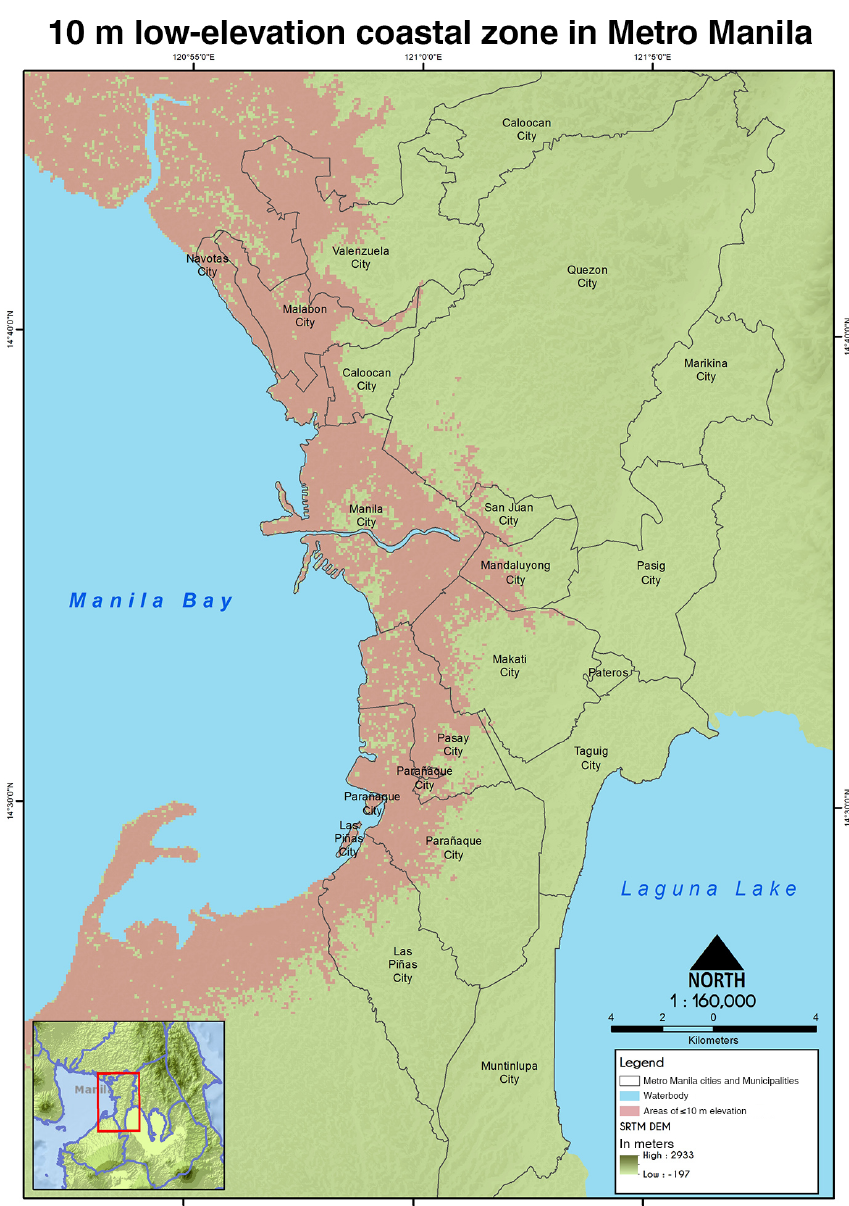
Figure 3. 10m low-elevation coastal zone in Metro